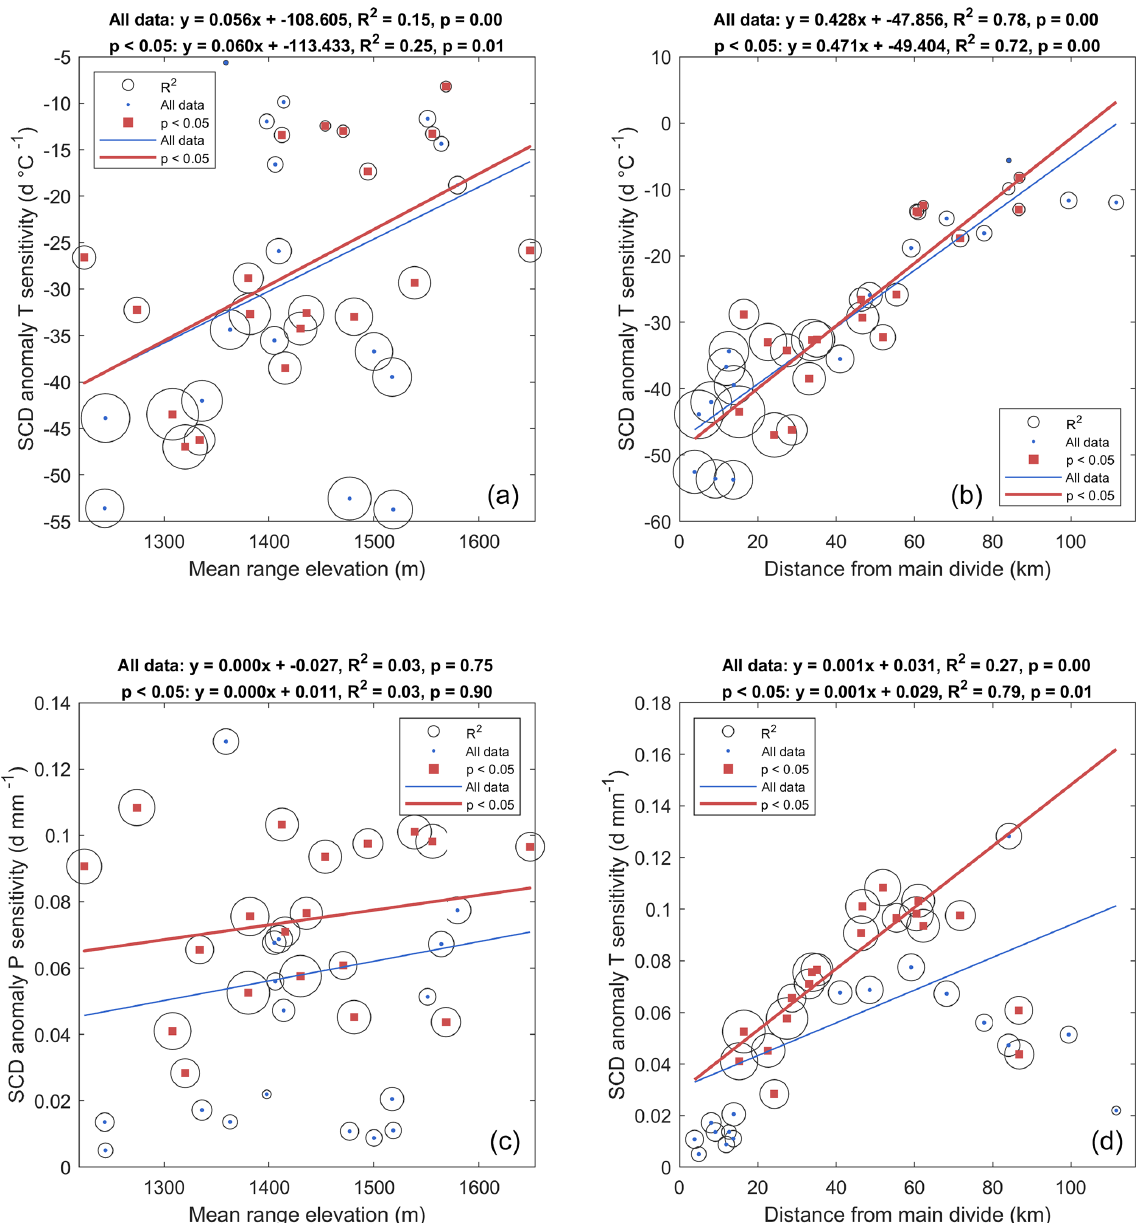
Figure 15. Regressions between the sensitivity of SCD to temperature (a, b) and precipitation (c, d) in terms of mean elevation of each range for areas above the median winter snowline (a, c) and distance of each range from the Main Divide (b, d) . In each case, regression is applied to all ranges, and to the subset for which p < 0 . 05 for range level sensitivity. Circular envelopes on data points are scaled by the R 2 values associated with the regression for each mountain